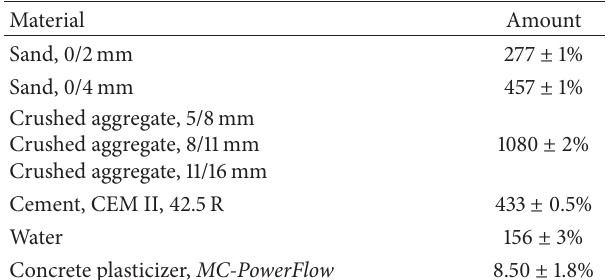
Table 2: Mixture proportion of the test specimens (kg/m 3 ).